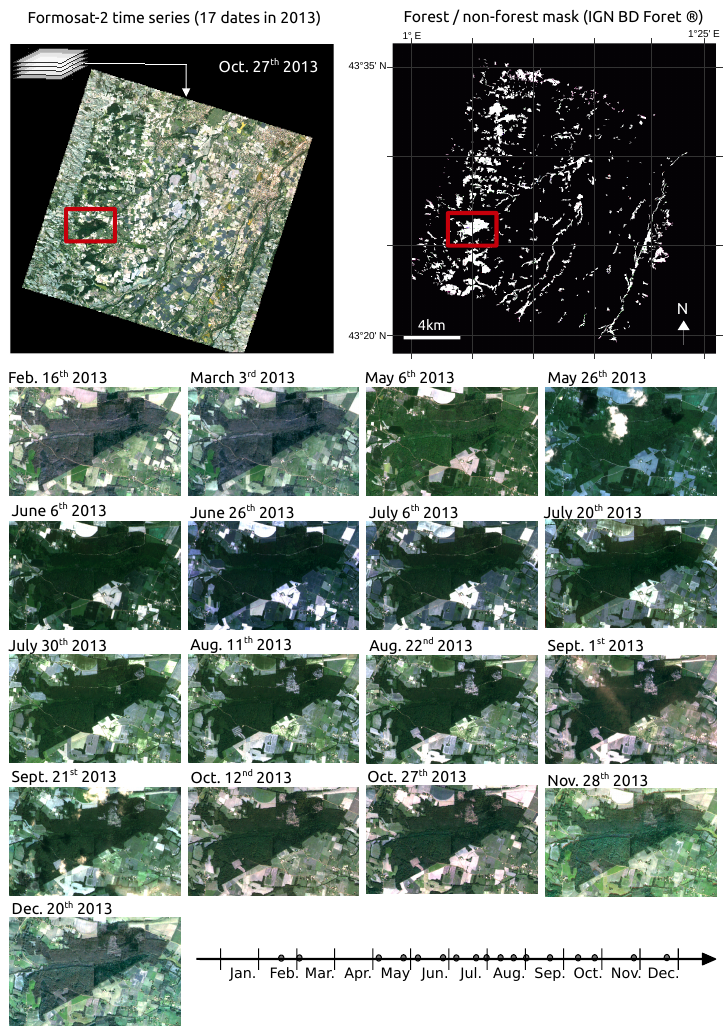
Figure 2. Dataset used in the study composed of a multispectral Formosat-2 time series of 17 dates covering a 24 km × 24 km area and a forest/non-forest mask derived from the French National Forest Inventory database. The Formosat images with excerpts focusing on one forest are viewed in true color